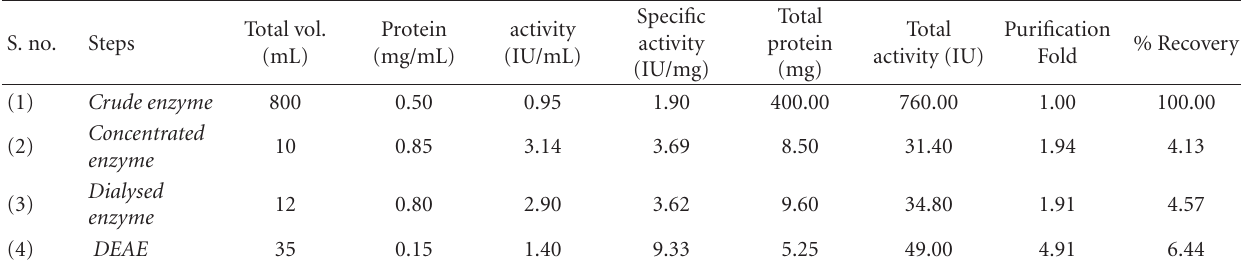
Table 1: Purification chart for Mn peroxidase from the culture filtrate of the fungal strain Fomes durissimus MTCC-1173. S.